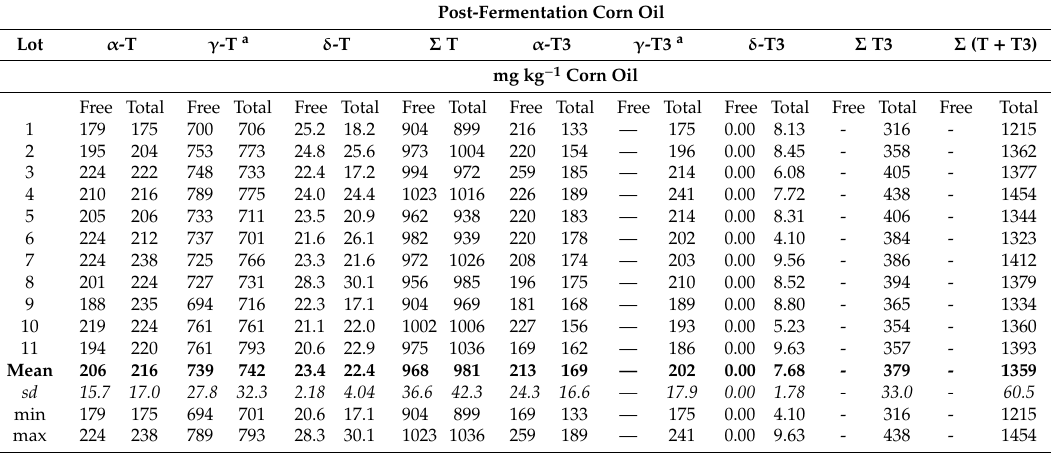
Table 3. Free and total amounts of tocopherols (T) and tocotrienols (T3) in post-fermentation corn oil from a dry-grind corn ethanol plant. Data refer to individual lots collected at monthly intervals from July 2018 to September 2019 and overall mean, standard deviation ( sd ), and range of values observed ( n = 11)